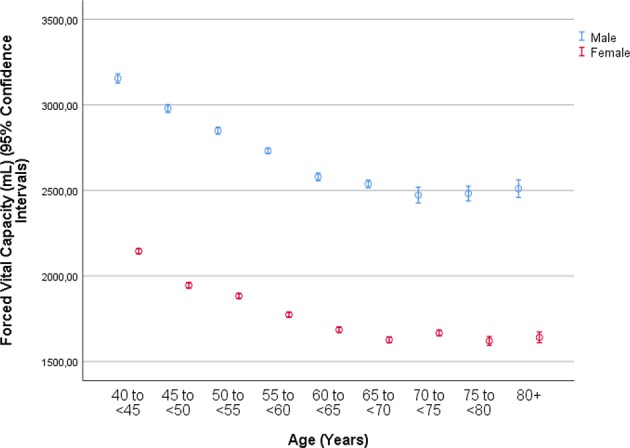
Graph showing the distribution of the forced expiratory volume in 1 s, stratified by age and gender, in the Ural Eye and Medical Study.